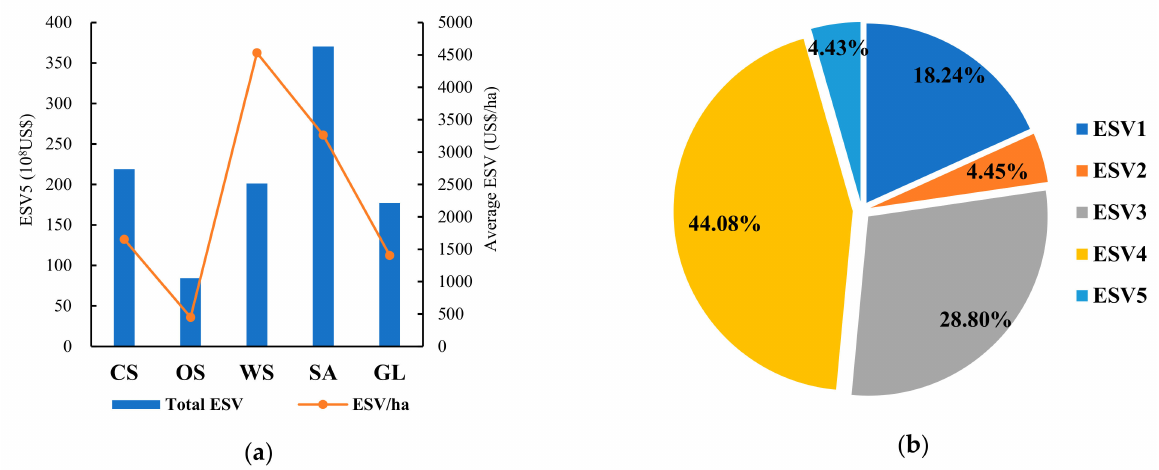
Figure 5. Statistical chart of total ESV of grassland ecosystem in Ethiopia. ( a ) the ESV of different types of grassland. ( b ) the proportion of each ecosystem service function in the total ESV. ESV1: organic matter production value, ESV2: promoting nutrient circulation value, ESV3: gas regulation value, ESV4: soil conservation value, ESV5: water conservation